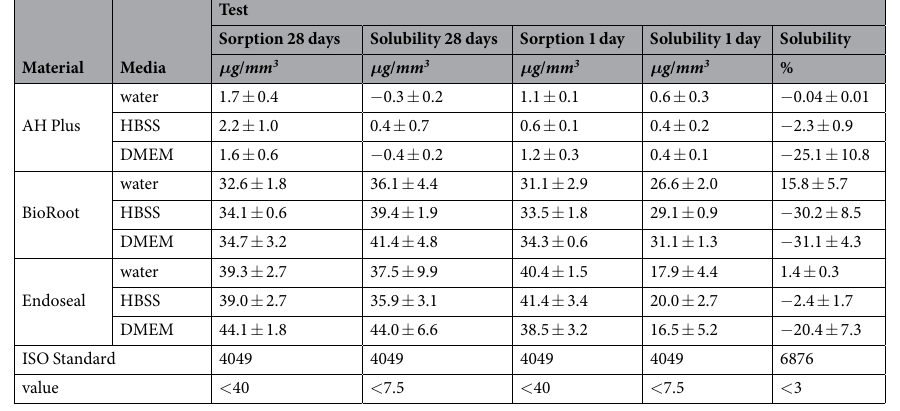
Table 3. Sorption and solubility values for test sealers using two standard methodologies (Mean ± SD). * MTA Fillapex did not set so the fluid uptake could not be